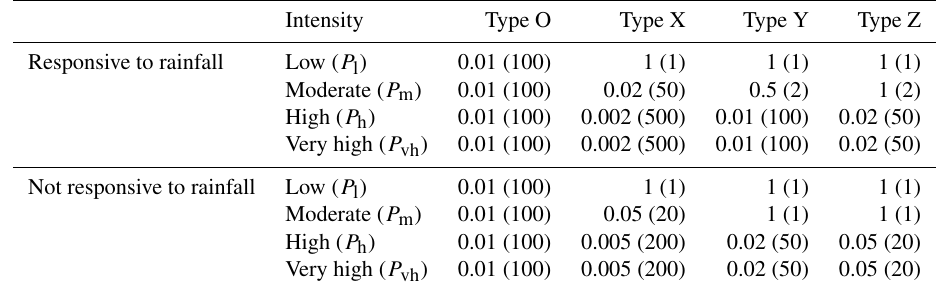
Table 10. Annual probability of exceedance of a damage level and (in parentheses) return period in years. Intensity Type O Type X Type Y Responsive to